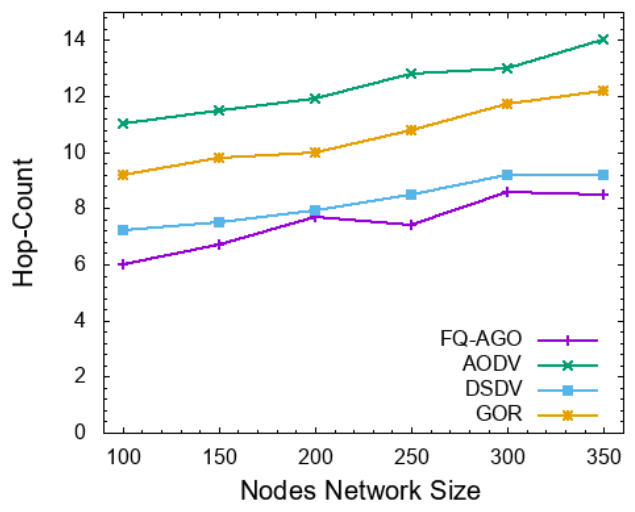
Figure 13. Hop-count vs. number of